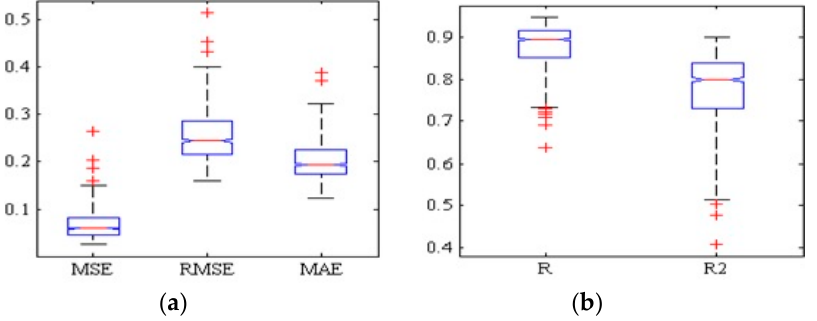
Figure 5. Boxplot of the evaluation criteria of the hybrid ANN–ABC method for estimating the BrimA value on spectral range around the wavelength of 962 nm at 1000 iterations. ( a ) Error measures: Mean Square Error (MSE), Root Mean Square Error (RMSE) and Mean Absolute Error (MAE). ( b ) Regression coefficient, R, and coefficient of determination, R 2 .